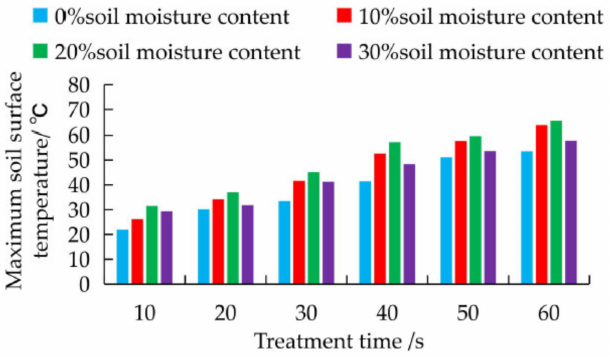
Figure 15. Soil surface temperature under 1.6 kW microwave output power.